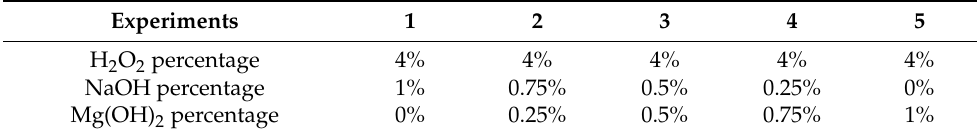
Table 3. NaOH/Mg(OH) 2 ratio variation during H 2 O 2